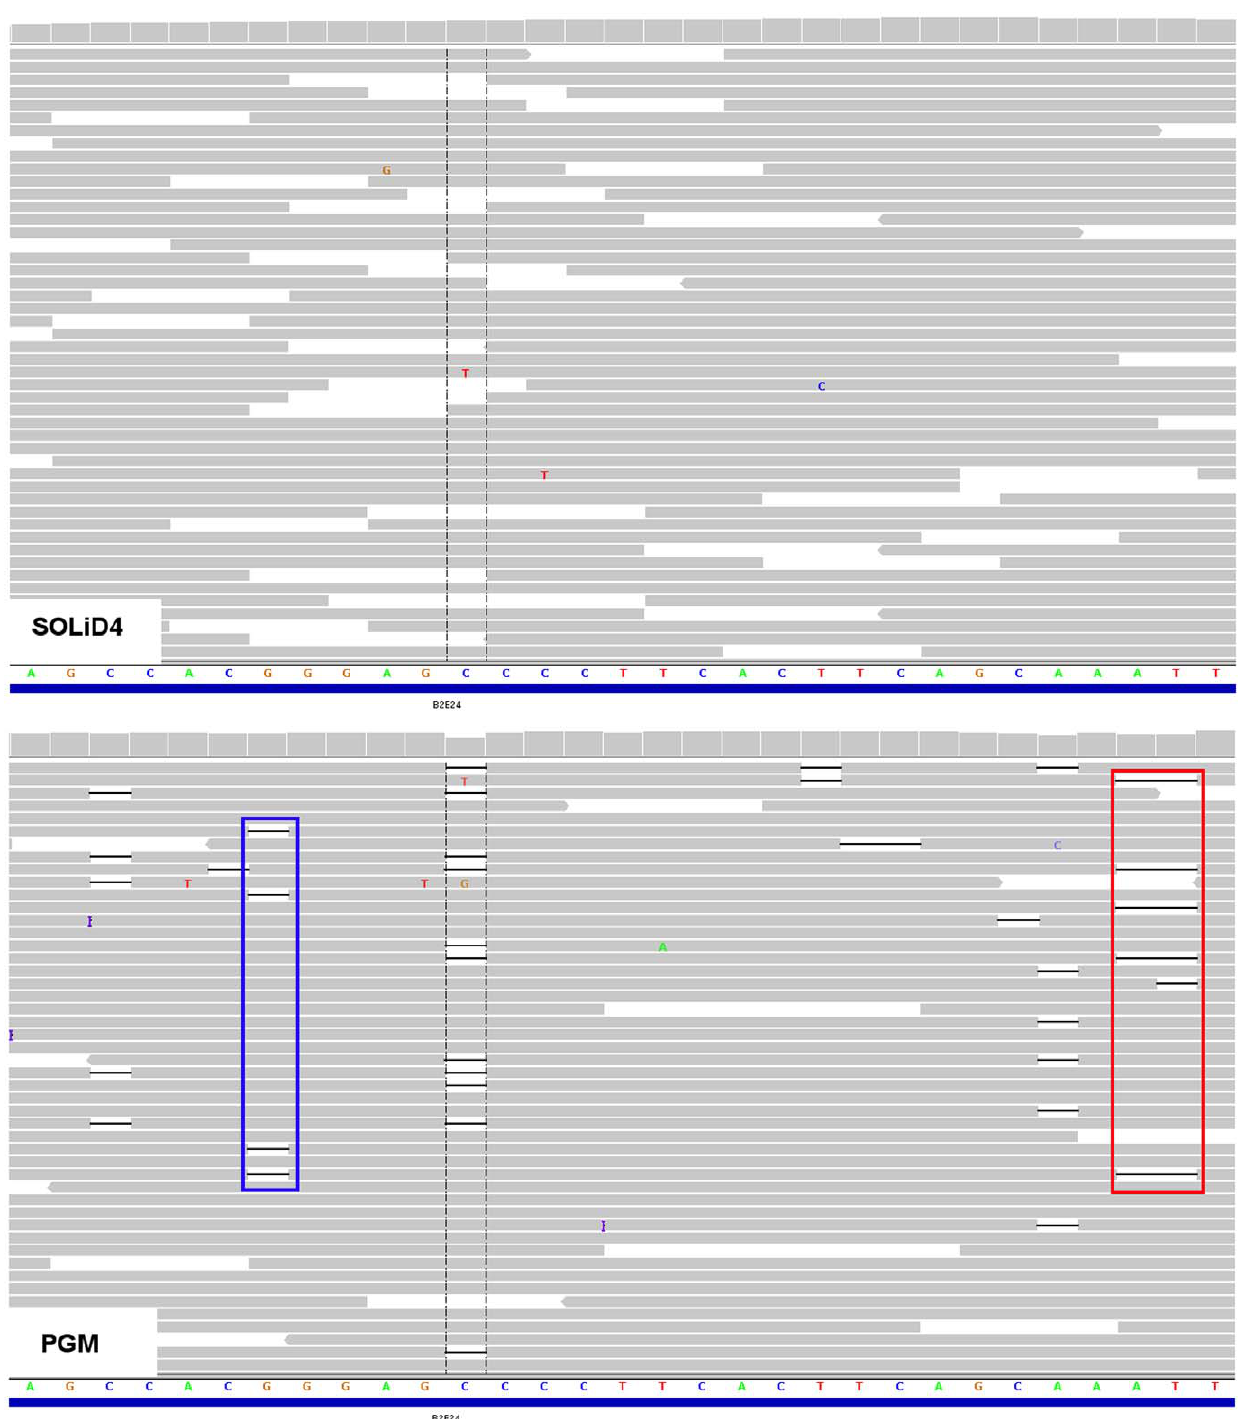
Figure 1. Comparison of read-pileups derived from SOLiD and Ion Torrent sequencing at a homopolymer region. Both top and bottom panels were IGV pileups derived from the SOLiD4 and Ion Torrent sequencing of exon 24 of the BRCA2 gene respectively. At the interval marked by two dotted lines, a deletion was detected in the PGM TM data. This deletion was not detected in SOLiD4 data. In addition, spurious gaps were observed in other sequence positions in the PGM TM data whereas none of these gaps were seen in the SOLiD4 data. Many of these spurious gaps were aligned to sequence positions which were followed by a run of the same nucleotide. The region highlighted by the red rectangular box indicates a false positive deletion that was associated with a non-zero VARW and the blue rectangular box indicates a false positive deletion that was associated with a low BAF.